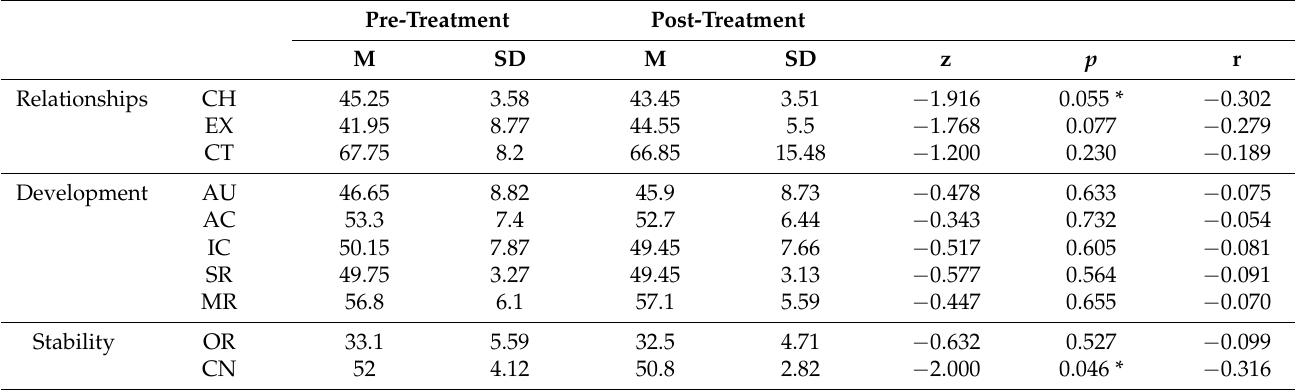
Table 9. Pre-post comparison of the control group. Family climate.